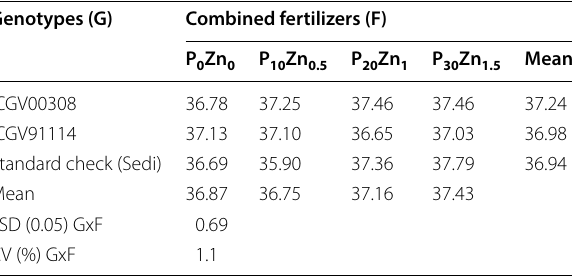
Table 7 The interaction effect of genotypes and PZn fertilizers on protein content